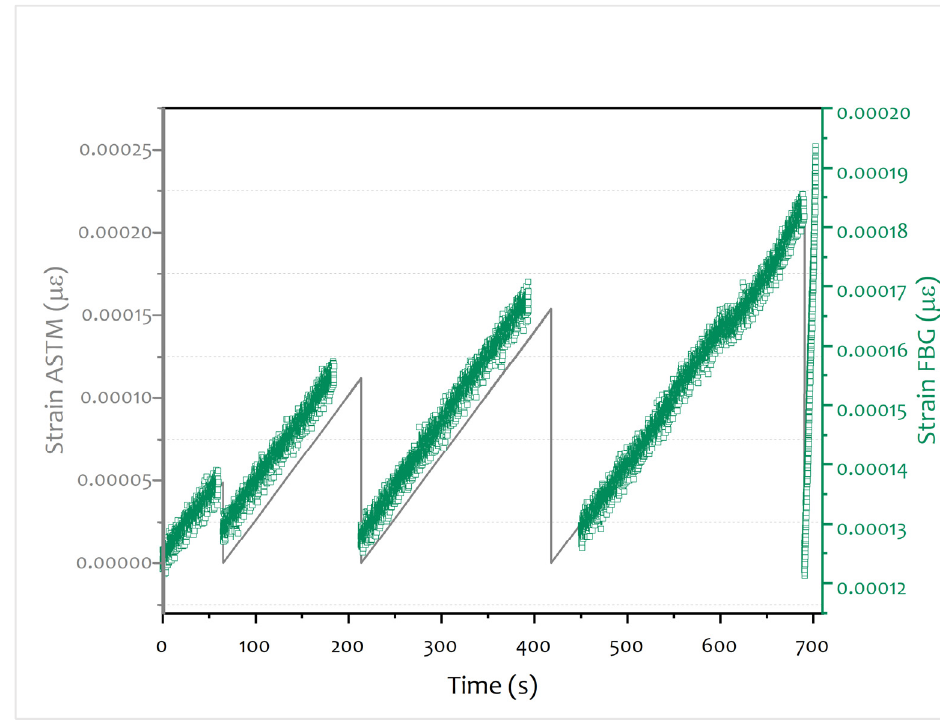
Figure 13. Load-unload cycles for the FBG instrumented henequen biolaminate, showing the evo- lution of strain by calculation (gray line) and FBG measurements (green dots). tion of strain by calculation (gray line) and FBG measurements (green